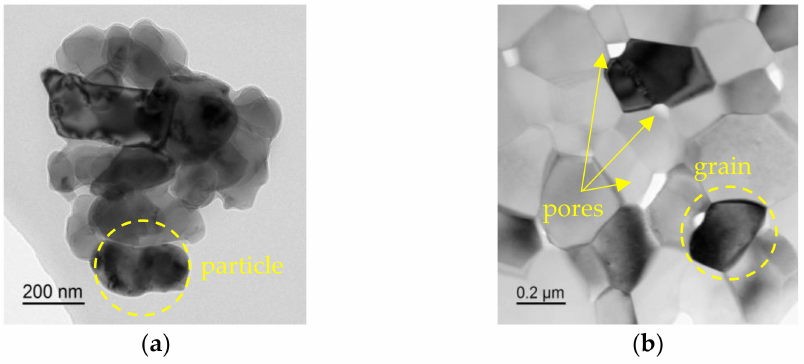
Figure 6. TEM images of Al 2 O 3 : ( a ) initial powder, ( b ) sample obtained at Т = 1400 ◦ C, V = 700 ◦ C/min ( ρ / ρ th = 0.92, d ~ 0.2–0.3 µ m). The pores are marked with